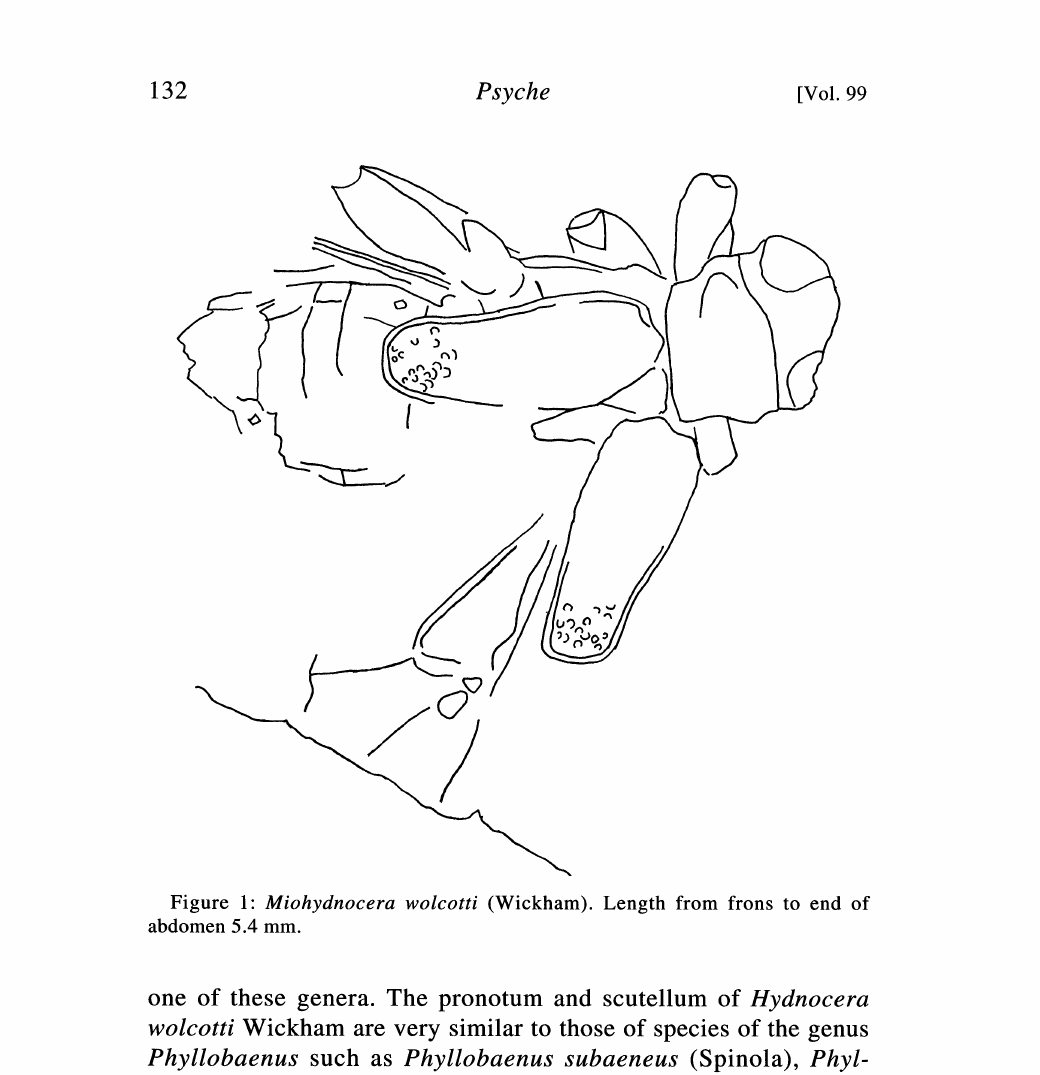
Figure 1: Miohydnocera wolcotti (Wickham). Length from frons to end of abdomen 5.4